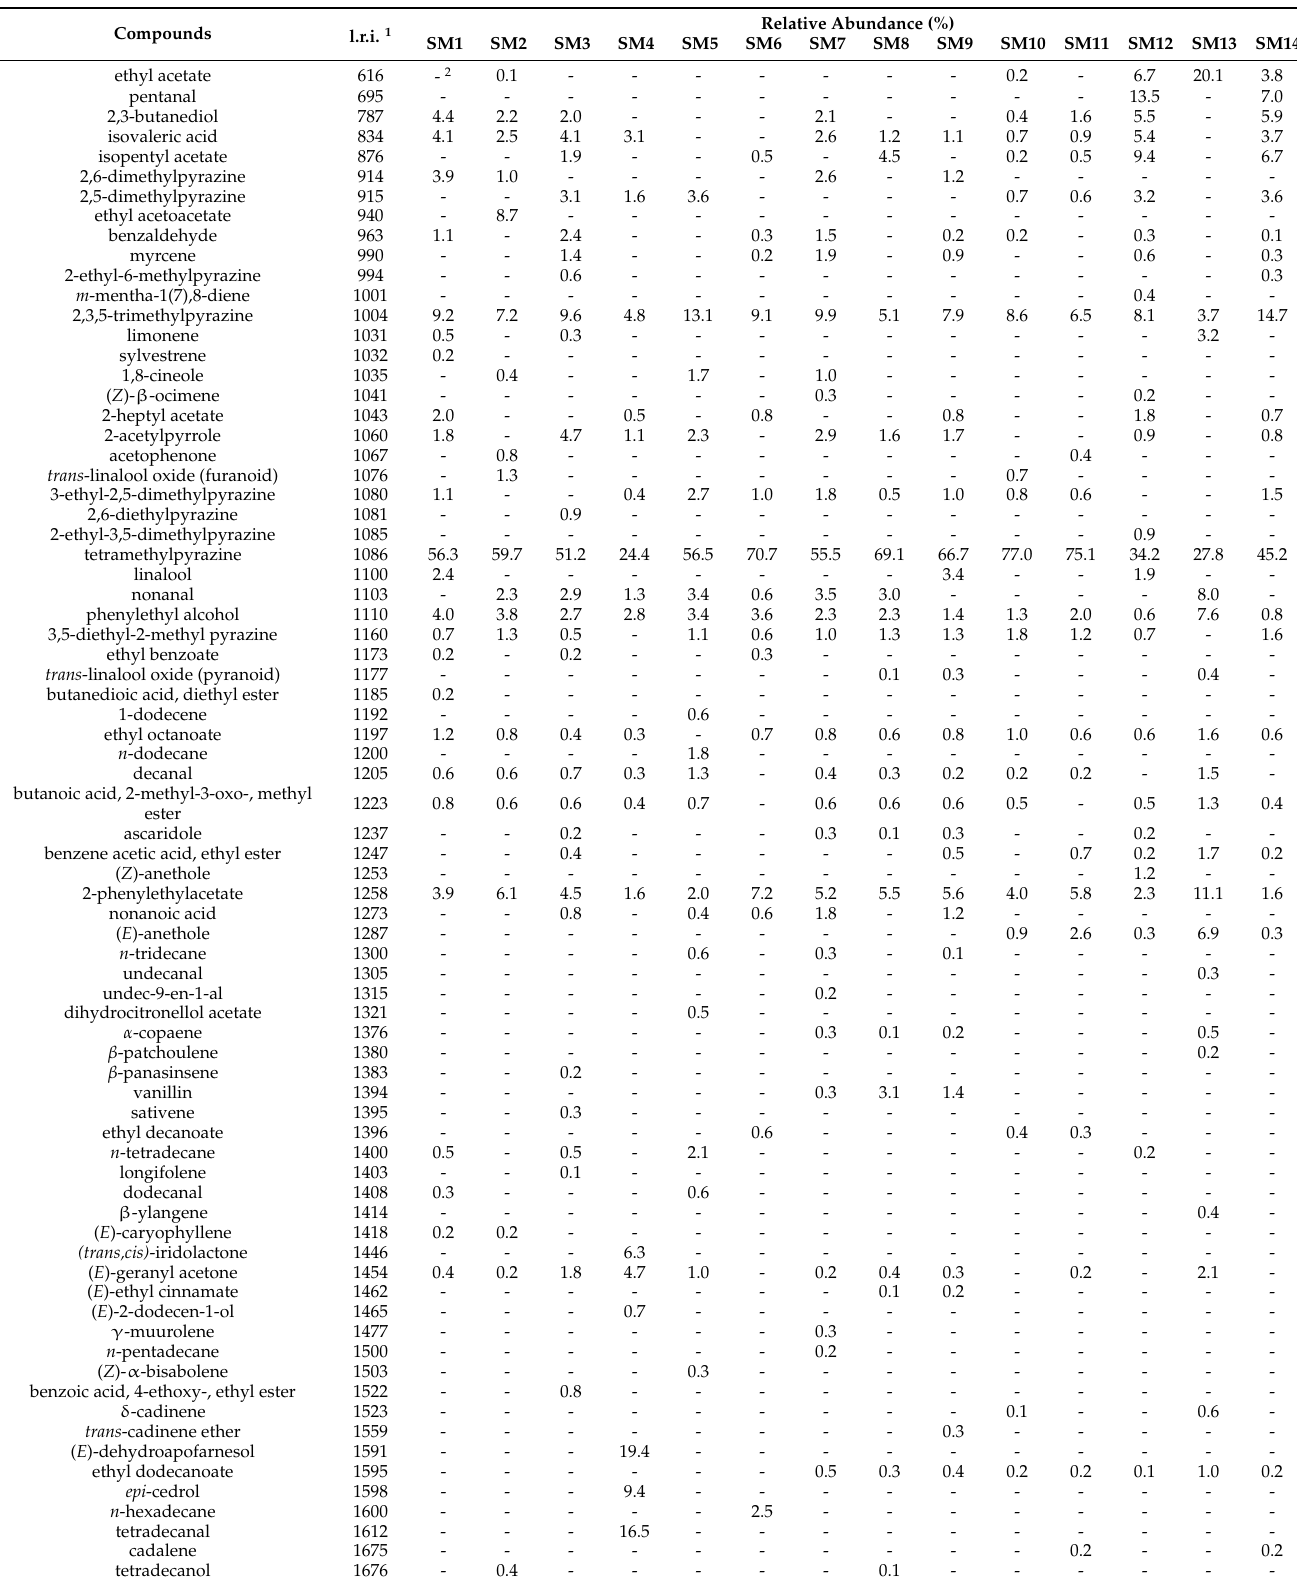
Table 4. Complete compositions of the headspaces sampled for supermarket chocolate bars (SM1 to SM14).